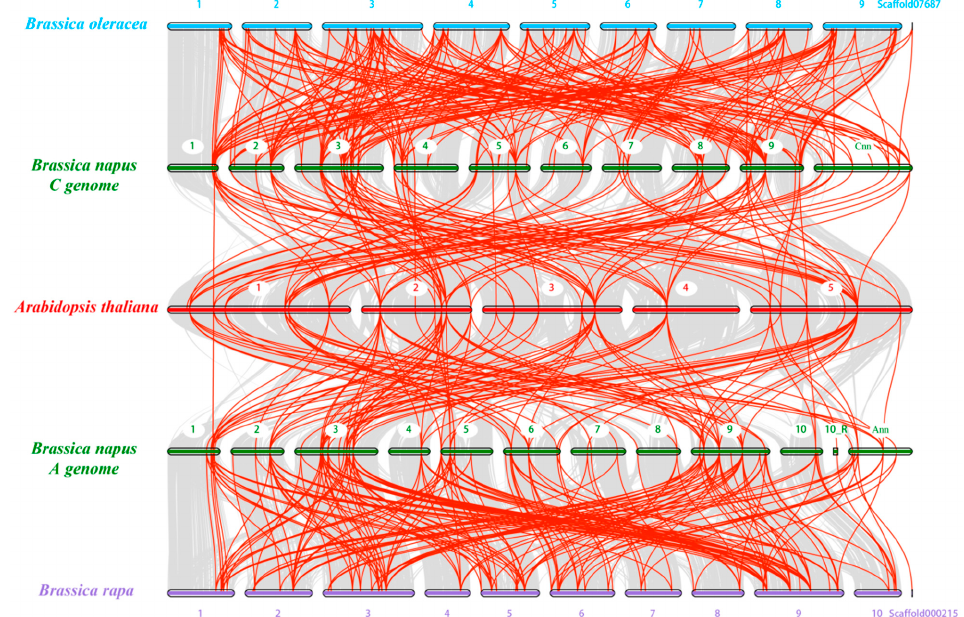
Figure 6. Collinearity analysis of the NF-Y family genes in B. napus , B. rapa , B. oleracea and Arabidopsis chromosomes. The solid bars with different colors represent different chromosomes of the four species. The gray lines in the background suggest the syntenic blocks between the genomes of two species for comparison, while the red lines indicate the syntenic NF-Y gene pairs. R: random.